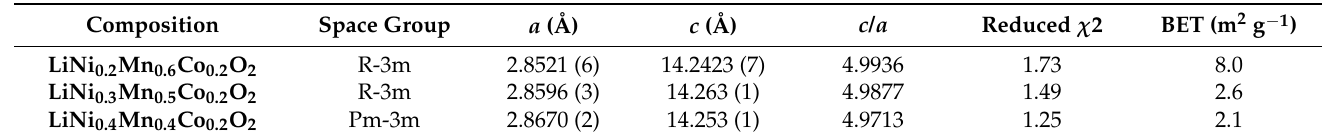
NMC262, NMC352, and NMC442 are presented in Table 1. Table 1. Structural composition, lattice parameters, intensity ratios and BET surface area of NMC cathodes with different compositions.